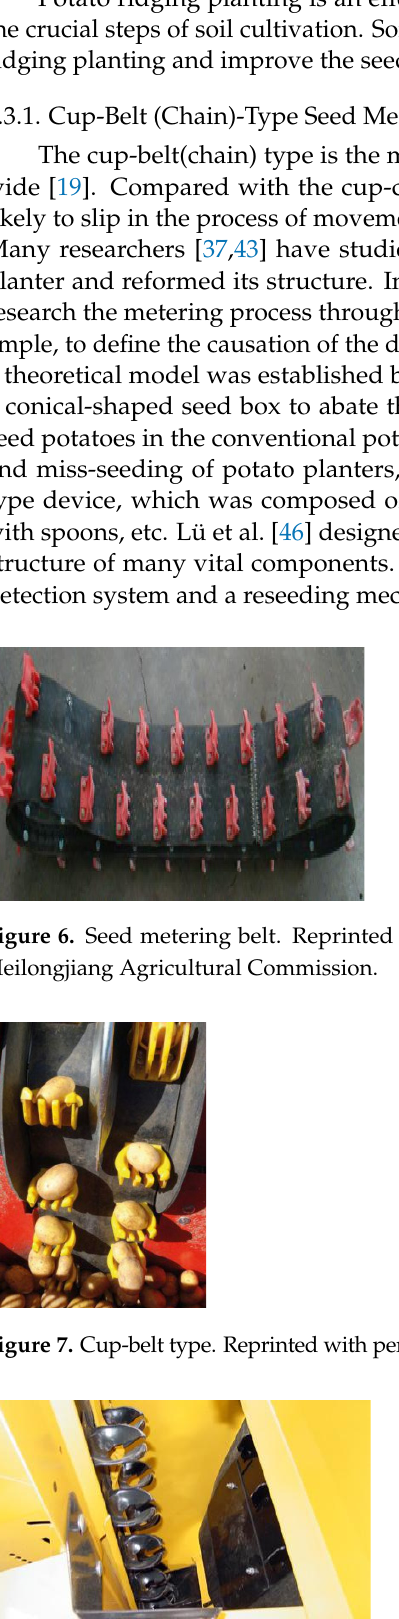
Figure 8. Cup-chain type. Reprinted with permission from ref. [50]. Copyright 2021 Double L In- dustries.